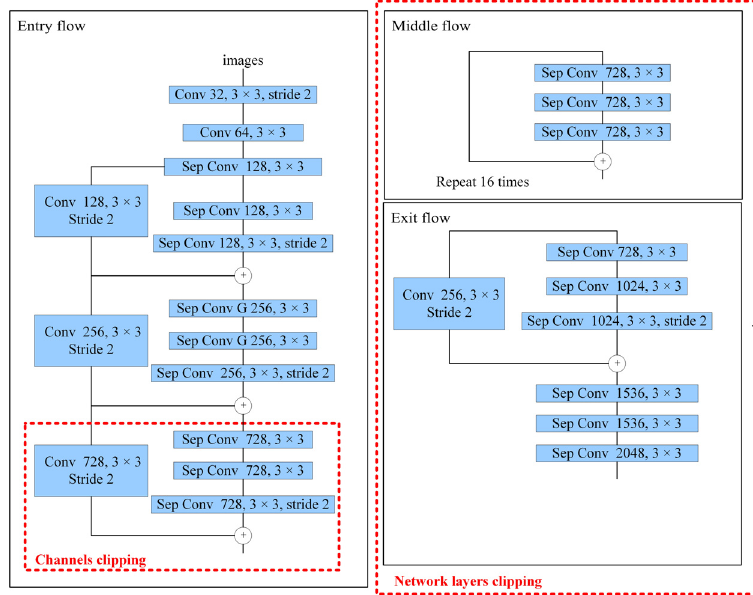
Figure 7 . Xception clip . Figure 7. Xception clip.